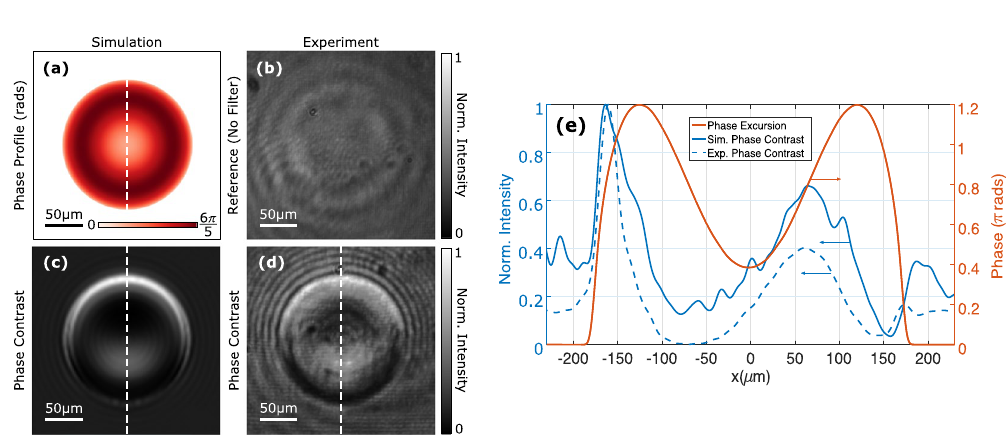
Figure 4. Image processing was performed on a transparent red blood cell ( a ) emulated by a spatial light modulator with a phase excursion of 6 π/ 5 . An experimental control image obtained in the absence of the notch filter is given in ( b ), while simulated ( c ) and experimental ( d ) phase images produced by the notch filter demonstrate phase visualization. The intensity images ( b )–( d ) are normalized to their brightest pixels, while the line profiles along the dashed lines shown in ( a ), ( c ) and ( d ) are given in ( e